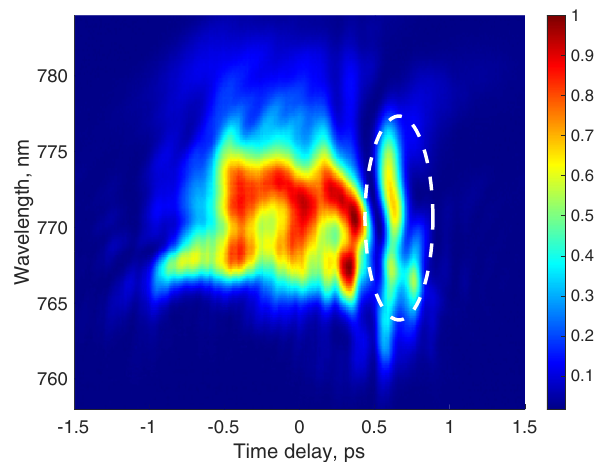
Figure 3: Spectrogram measured by XFROG of the pulse profile for a TI-QD biased to 5 kA/cm 2 and for an excitation power of 6